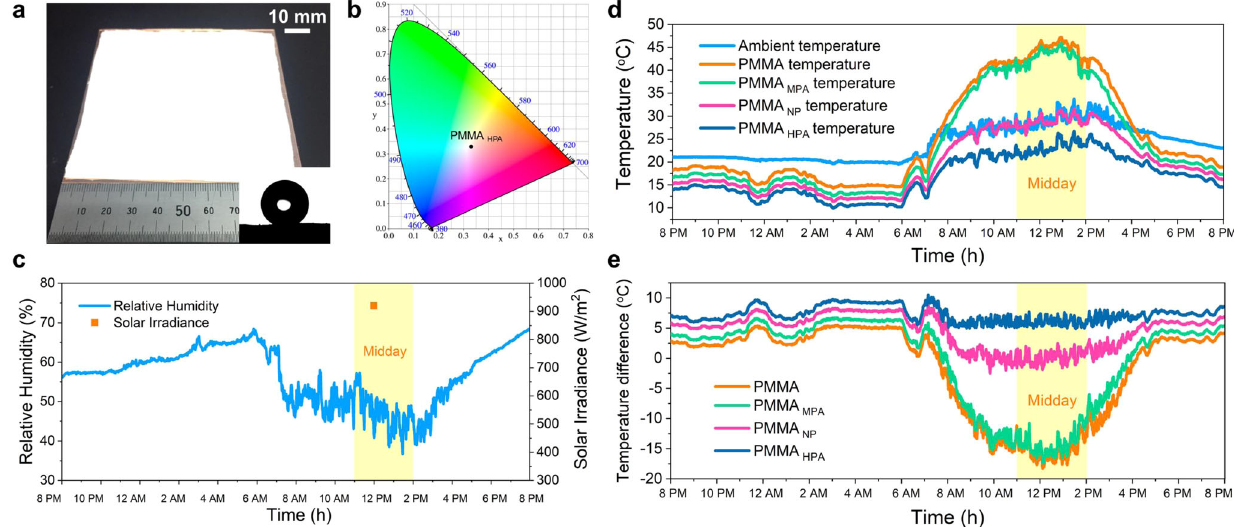
Fig. 5 Twenty-four-hour continuous passive radiative cooling performance measurements. a Photograph of the cooling PMMA HPA fi lm showing its bright white appearance (inset, water contact angle image of PMMA HPA ). b CIE chromaticity coordinates of the cooling PMMA HPA fi lm. c Relative humidity tracking of the air and solar irradiance at 12 PM on 10 Oct. 2019. d Temperature tracking of the air and PMMA fi lms. e Temperature difference between the ambient and structural PMMA fi